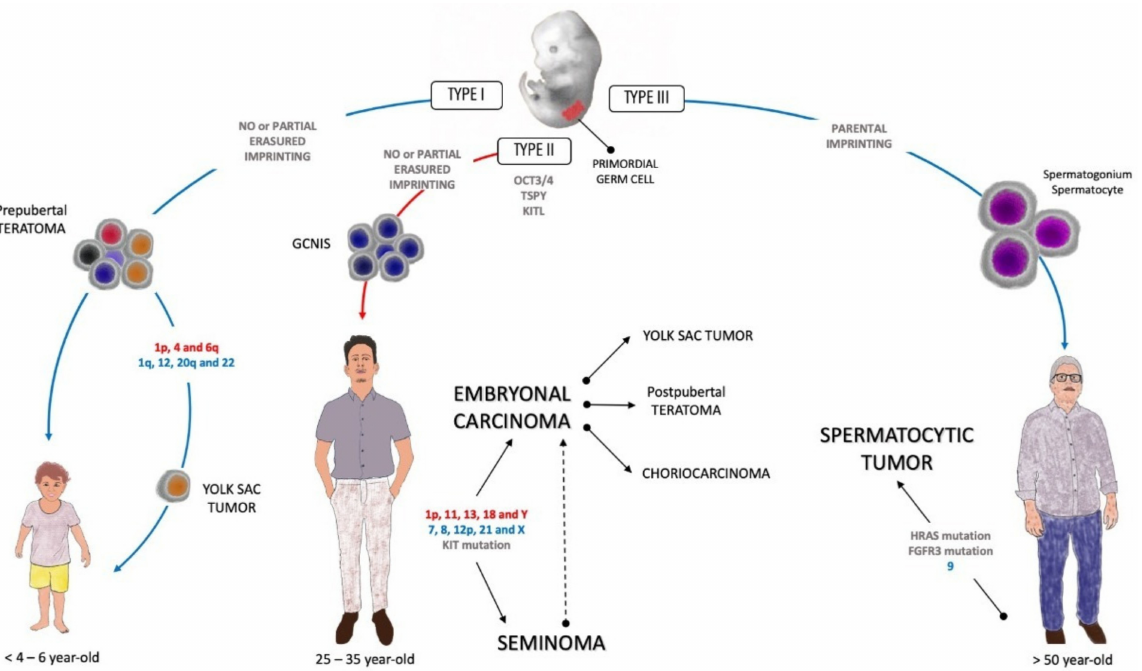
Figure 1. Etiopathogenesis of testicular germ cell tumors (TGCTs). The red letters mean chromosomic loss, and the blue letters chromosomic gain. The blue arrows represent the non-GCNIS pathway and the red arrow represents the GCNIS pathway. GCNIS: germ cell neoplasia in situ; KITL: KIT ligand; TSPY: testis-specific Y-encoded